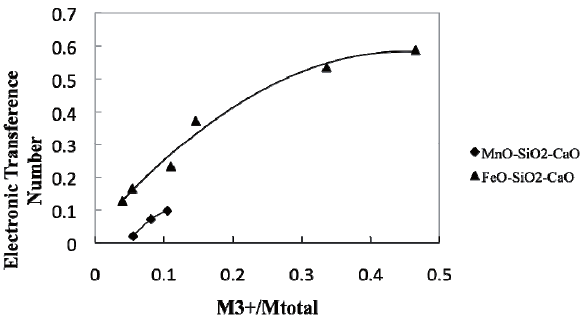
Figure 5. Transference number results at 1773 K for MnO- CaO-SiO 2